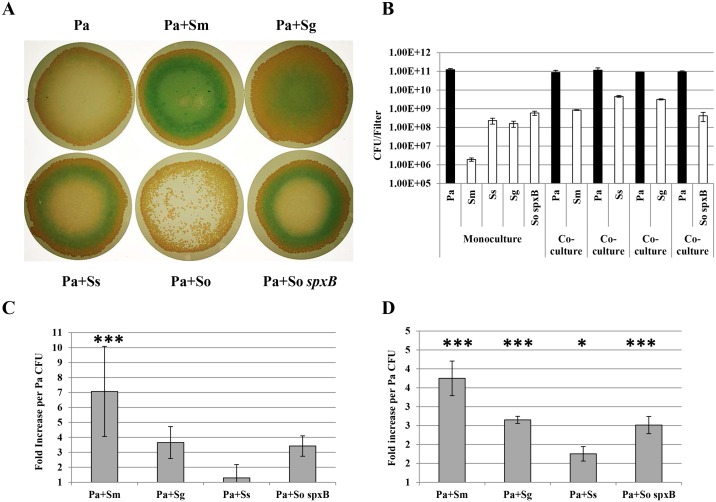
Population dynamics and virulence factor production in co-culture biofilms.Bacterial strains—Pa, P. aeruginosa CF2004; Sm, S. mitis NCTC 12261T; Sg, S. gordonii NCTC 7865T; Ss, S. sanguinis NCTC 7863T; So, S. oralis ATCC 35037T and So spxB, S. oralis ATCC 35037T
spxB mutant. Inoculation ratios for Pa:Sm, Pa:Sg, Pa:Ss, Pa:So and Pa:So spxB were 1:6, 1:18, 1:24, 1:6 and 1:5 respectively. (A) Biofilms formed on nitrocellulose filters after 48 h (37°C, 10% CO2). (B) Quantitative bacteriology (CFU / filter) of monoculture and co-culture biofilms sampled after 48 h (at 37°C, 10% CO2); shaded bars P. aeruginosa CF2004 population, unshaded bars streptococcal population; significant differences between cfu in monocultures and co-cultures (p<0.001***) using two-tailed t-test were observed for all streptococci with the exception of the S.oralis spxB mutant. (C) Pyocyanin and (D) elastase activity per P. aeruginosa cfu. Fold increase in co-culture biofilms compared with mono-culture control displayed. Biofilms sampled after 48 h (at 37°C); standard deviation of triplicate or quadruplicate cultures shown. Results significantly different from control using ANOVA with Holm Sidak post hoc test are denoted with an asterisk (*p<0.05, ***p<0.001). A significant fold-increase in pyocyanin was also observed between the Pa+Sm / Pa+Ss pairing (p<0.001) and for elastase production significant increases were observed for the following pairings; Pa+Sm / Pa+Ss, Pa+Sm / Pa+So spxB (p<0.001), Pa+Sm / Pa+Sg (p<0.01) and Pa+Sg / Pa+Ss (p<0.05).